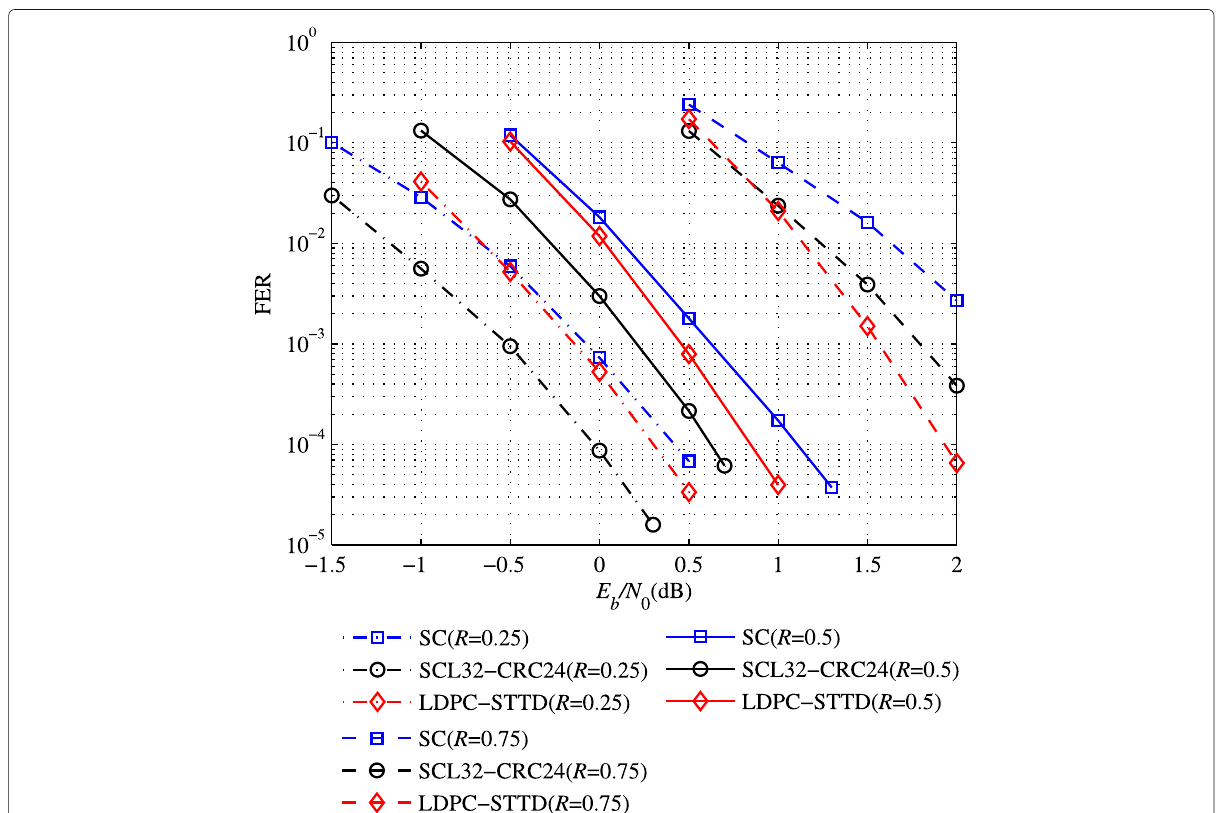
Fig. 6 FER performance of 2 × 2 polar-coded STTD system and LDPC-based STTD system. The frame error rate performance of polar-coded STTD system with two transmit antennas and two receive antennas, comparing with the LDPC-coded STTD system. SC decoding and SCL decoding are both